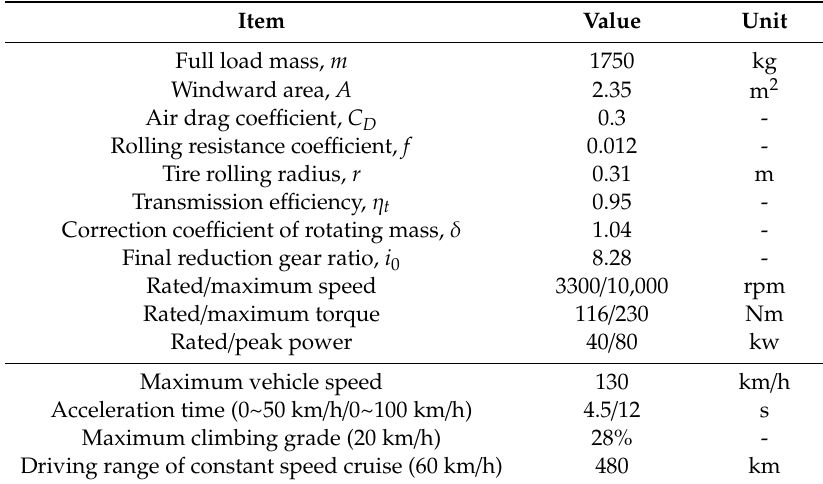
Table 1. Target vehicle parameters and performance indicators.